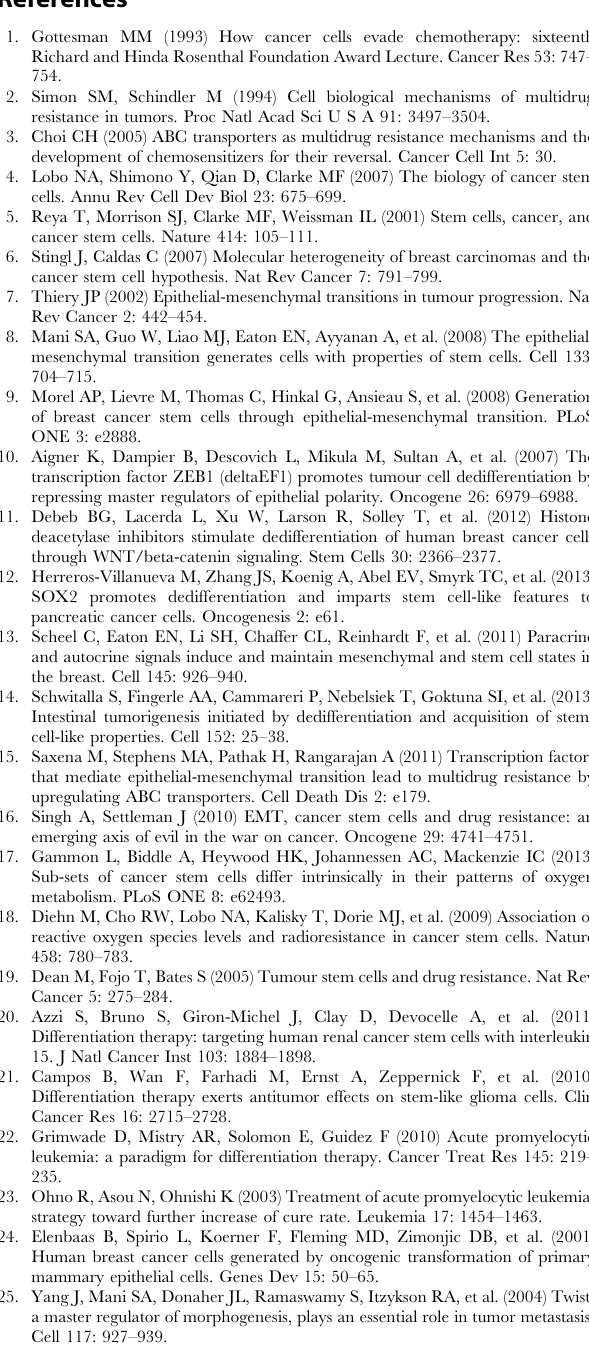
Table S4 Genes up-regulated upon treatment with menadione. Table S5 ROS-responsive genes pre-activated in HMLE-Twist cells. Table S6 Differentially expressed Nrf2 target genes.